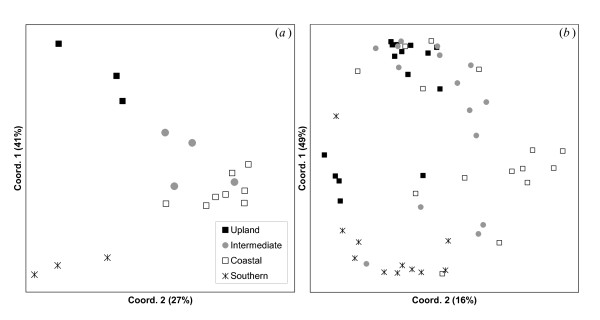
PCoA of genetic and morphological data. Plots of the first two principal coordinates obtained for T. speciosissima from the principal coordinate analysis of: a) pairwise genetic distances (by population) and b) morphometric distances (by individual).